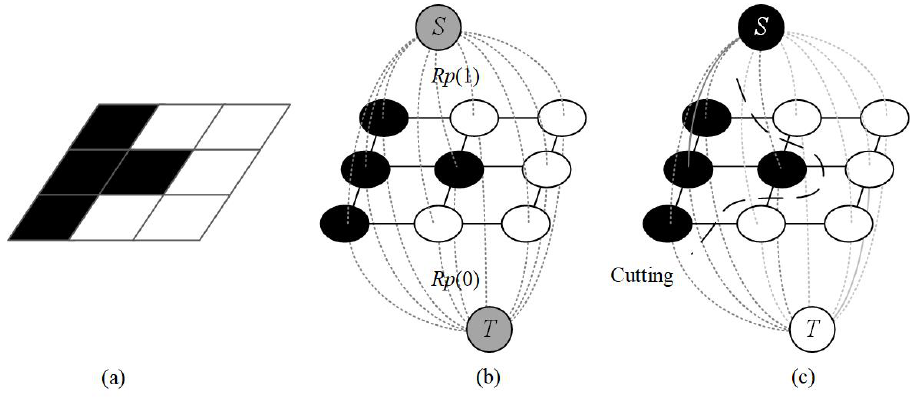
Figure 3. Graph Cuts for optimization. (a) Original data structure. (b) Constructed graph. (c) Cut of the